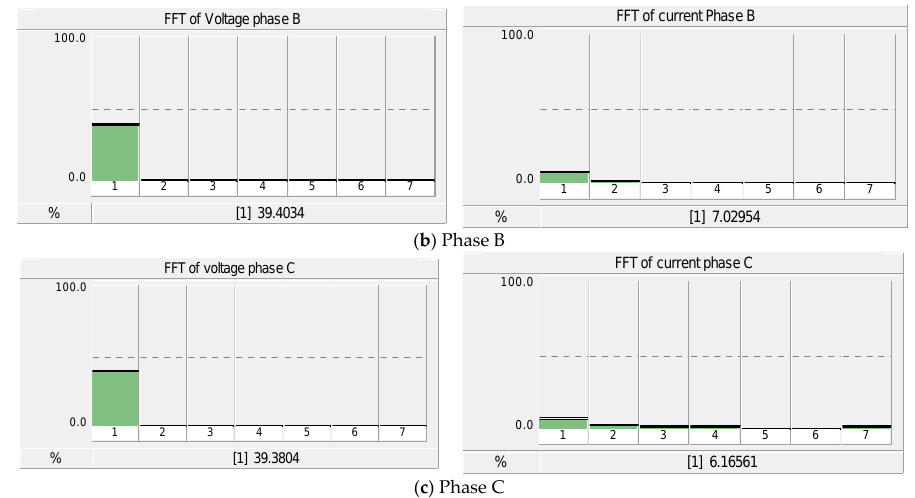
Figure 22. The frequency spectrums of the phase voltage and current at the LV side (0.4 kV) transformer 500 kVA when the BRKA open circuit is at 0.5 s.